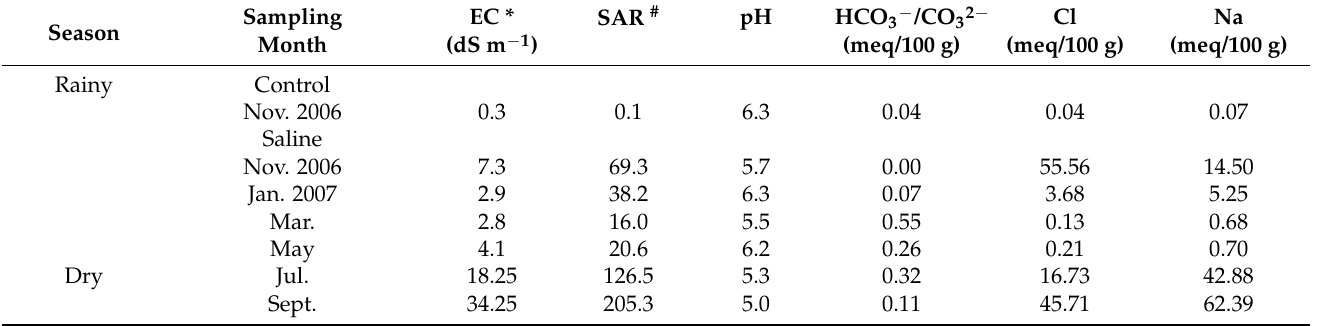
Table 1. Salinity levels in the saline wetland at the Ogongo Campus during the 2006–2007